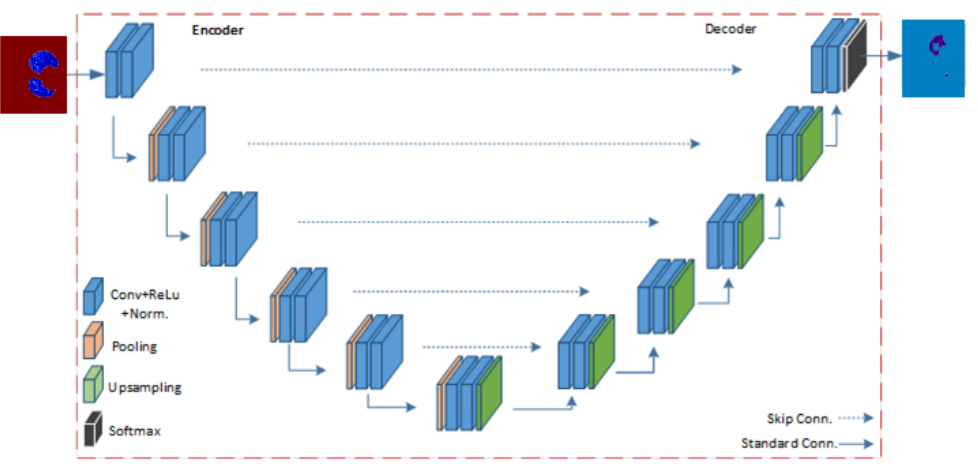
Fig. 5. Modified U-Net architecture,